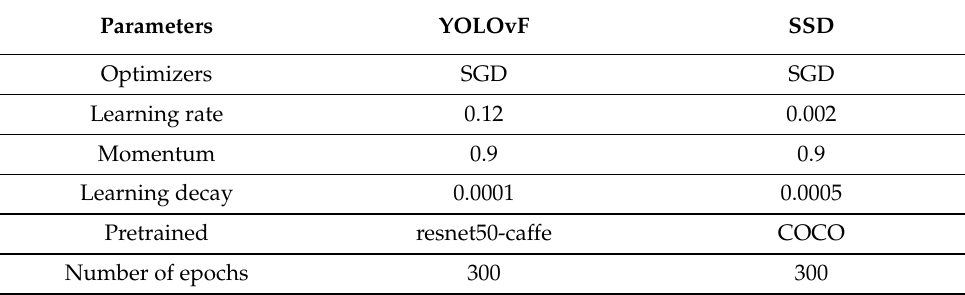
Table 2. Parameters used for training the YOLOvF and SSD